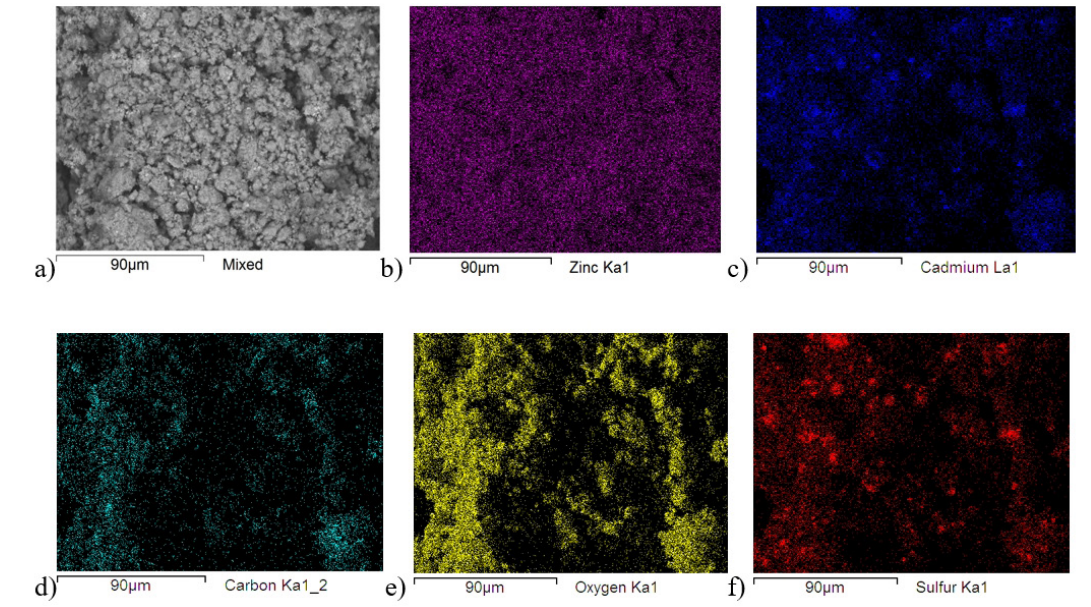
Cd S: a) Original SEM; b) Zinc; c) Cadmium; d) Carbon; e) Oxygen and 0.5 0.5 Cd S material. 0.5 0.5